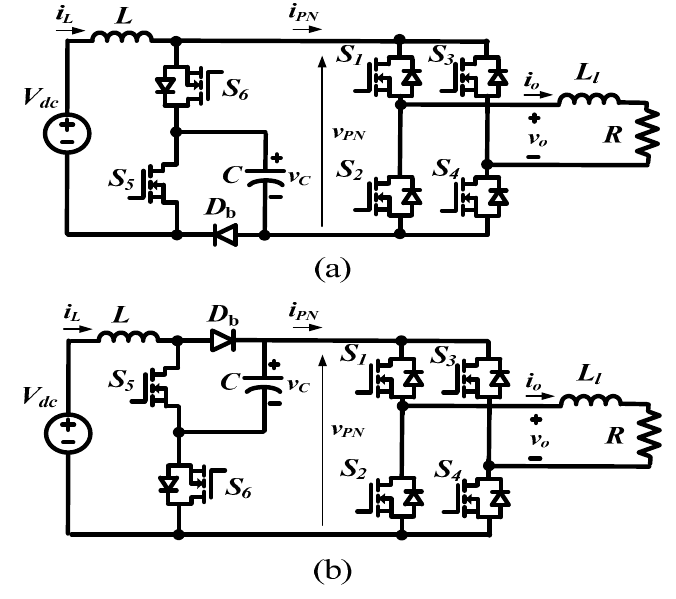
Figure 5. Improved single-phase qSBIs; ( a ) type 1 and ( b ) type 2.